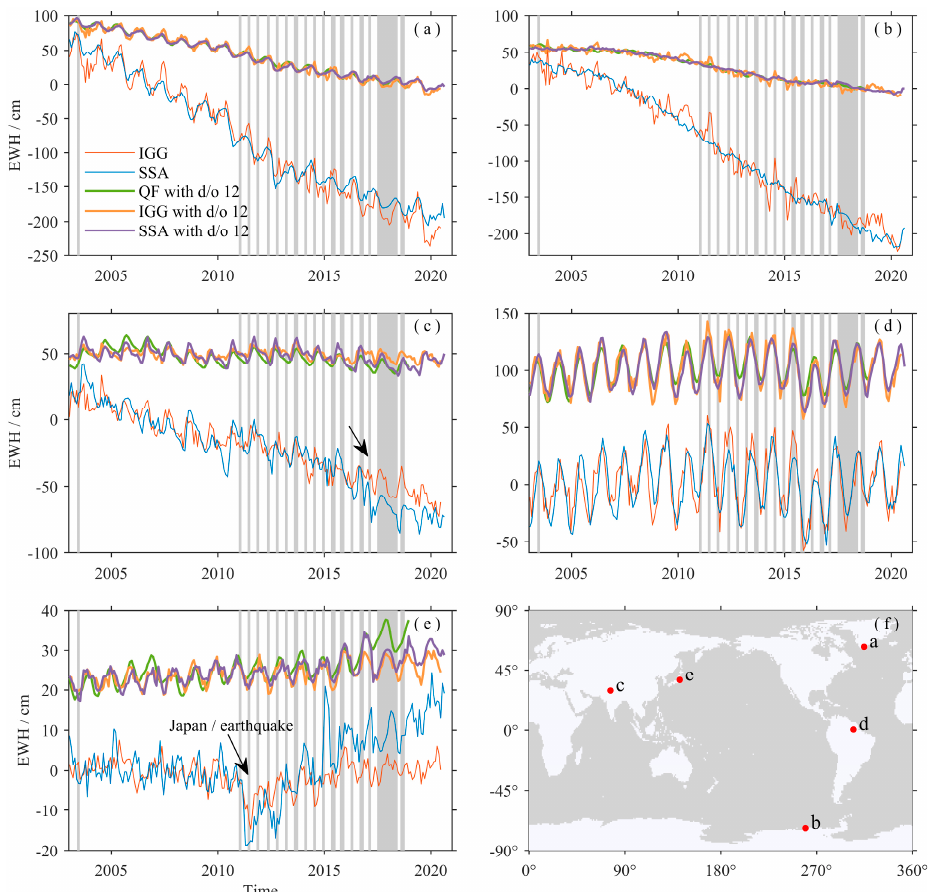
Figure 4. EWH time series from five sites in well-studied regions: ( a ) Greenland, ( b ) Antarctica, ( c ) north India, ( d ) Amazon, ( e ) eastern Japan. Subplot ( f ) shows the locations of these five sites. The gray ribbons represent the data gaps.